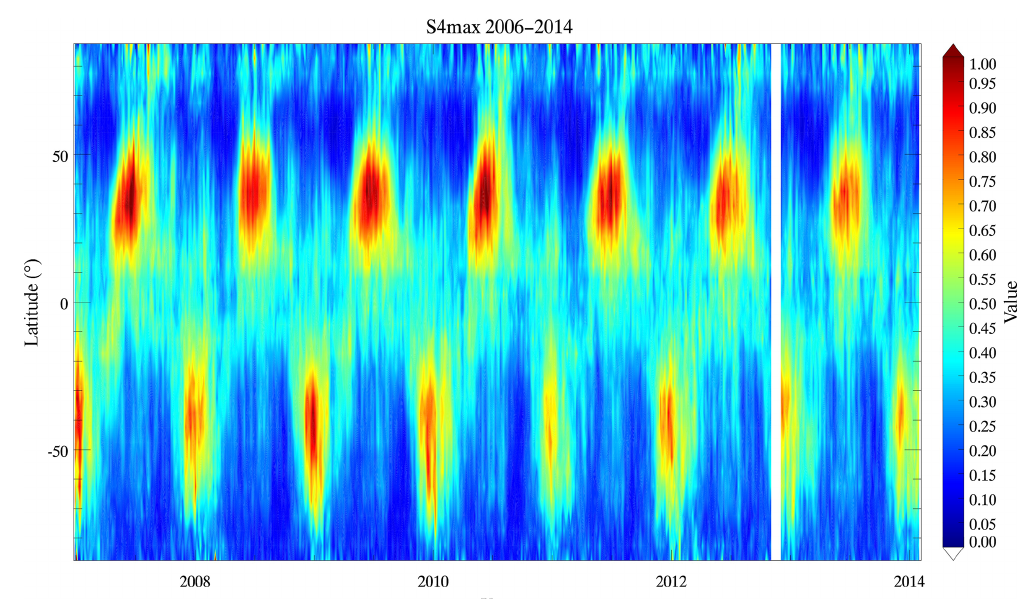
Figure 3. Time series of E s intensity with a resolution of 5 ◦ latitude × 5 days for the period from December 2006 to January 2014.